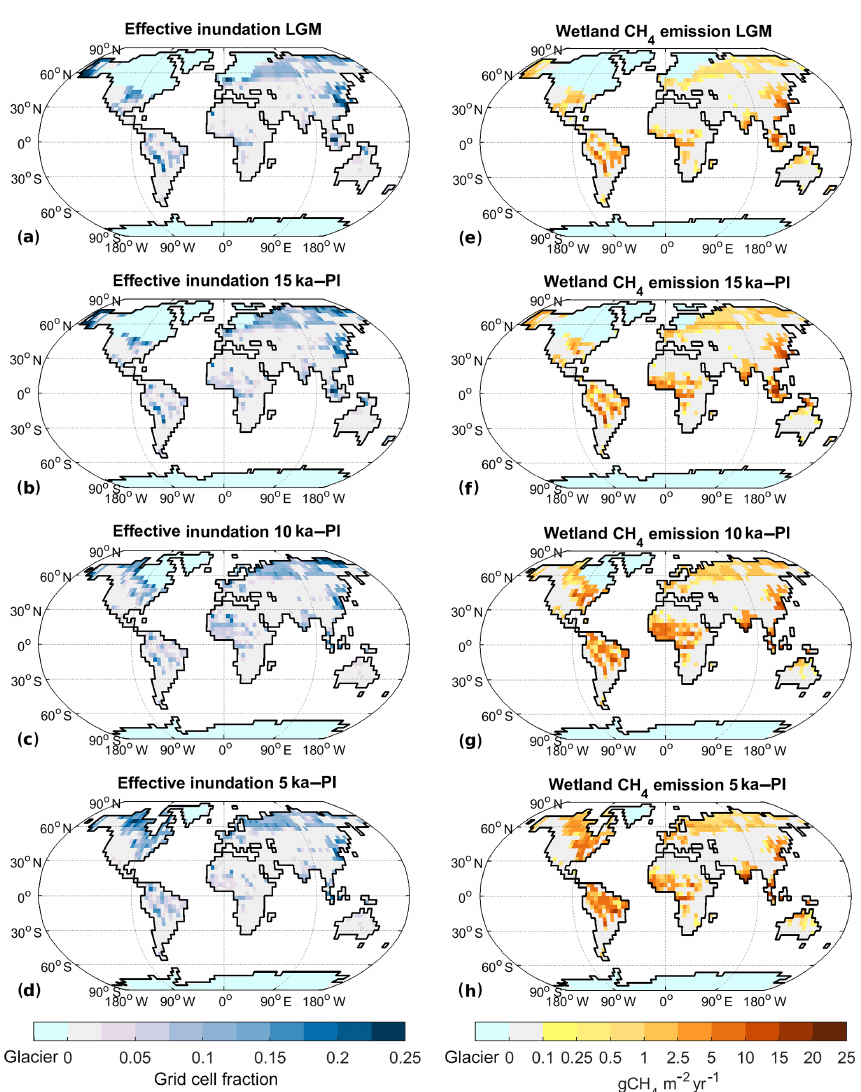
Figure B3. Absolute effective inundation and wetland CH 4 emissions for past climate states: (a–d) effective inundation, (e–h) wetland CH 4 emission. (a, e) LGM, (b, f) 15ka, (c, g) 10ka, and (d, h)